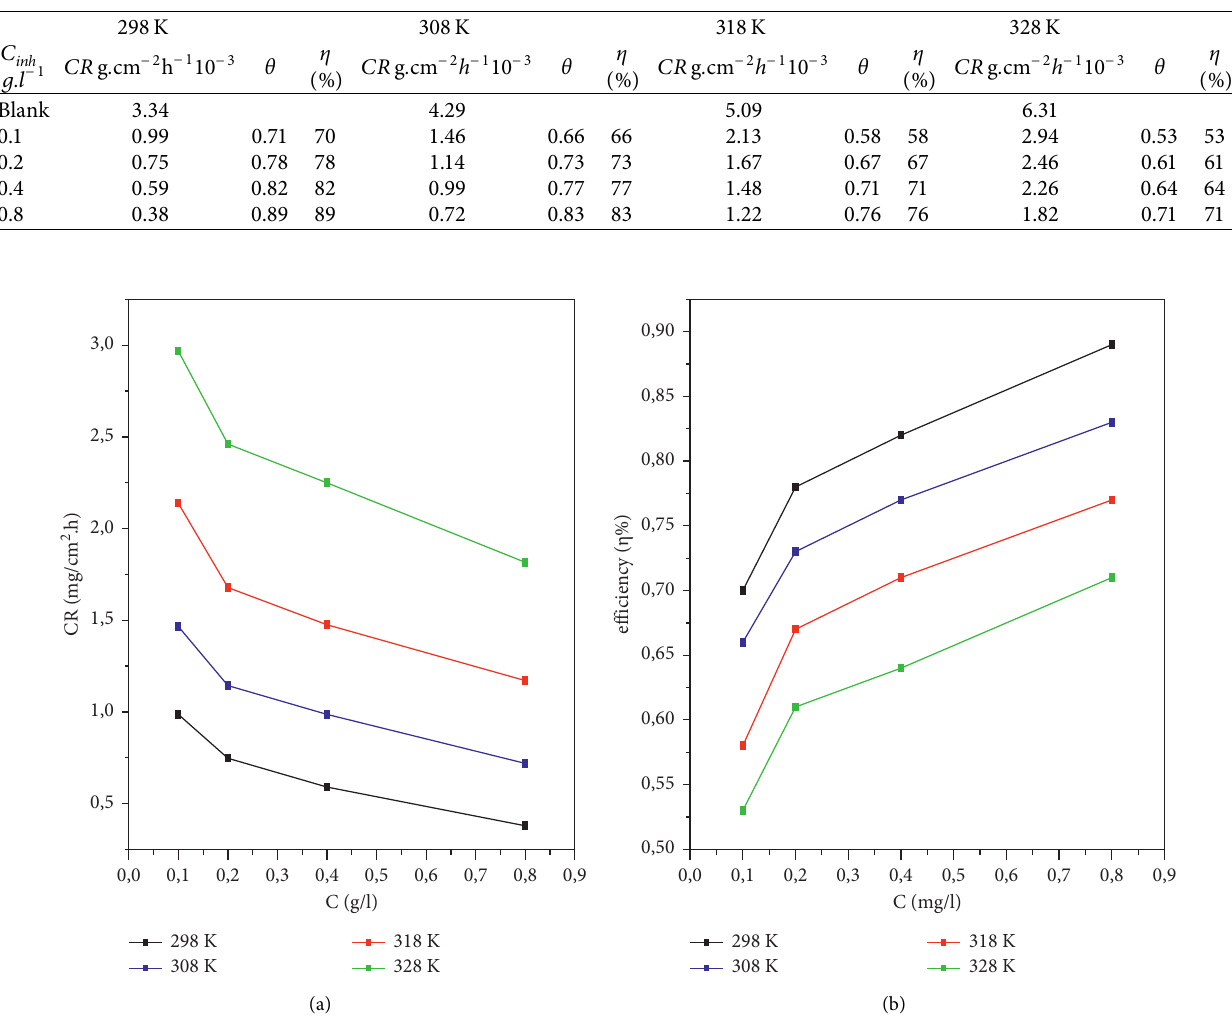
Figure 3: (a) Inhibition efficiency and (b) corrosion rate with the effect of temperature for different concentrations of the extract